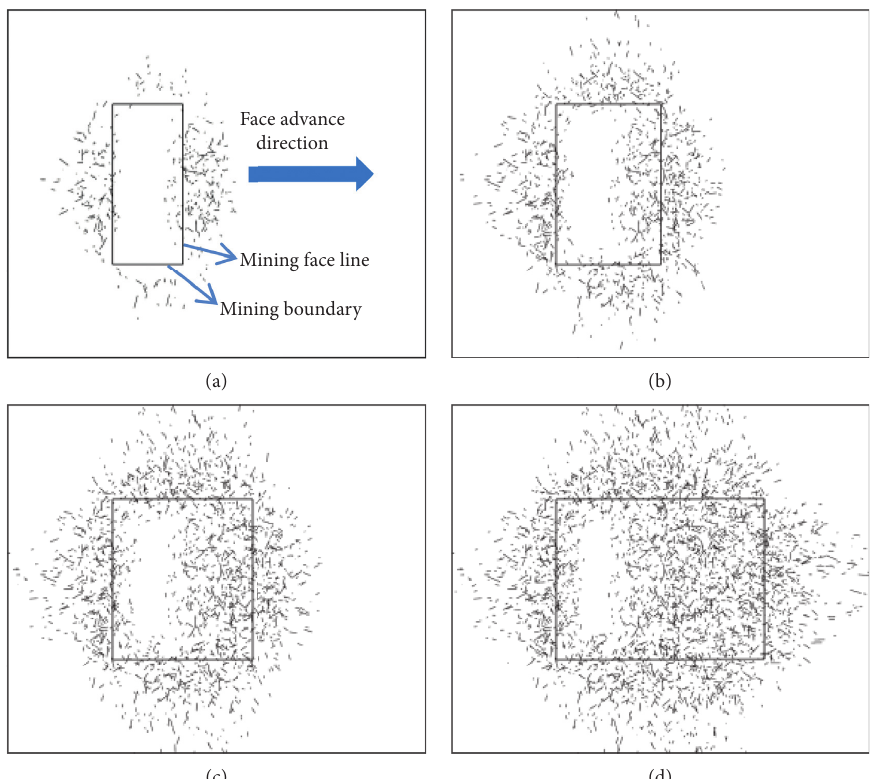
Figure 13: Evolution of the fracture network in the typical higher strata (medium sandstone 1) with mining advance based on horizontal section planes: (a) 100m; (b) 150m; (c) 200m; (d) 300m.